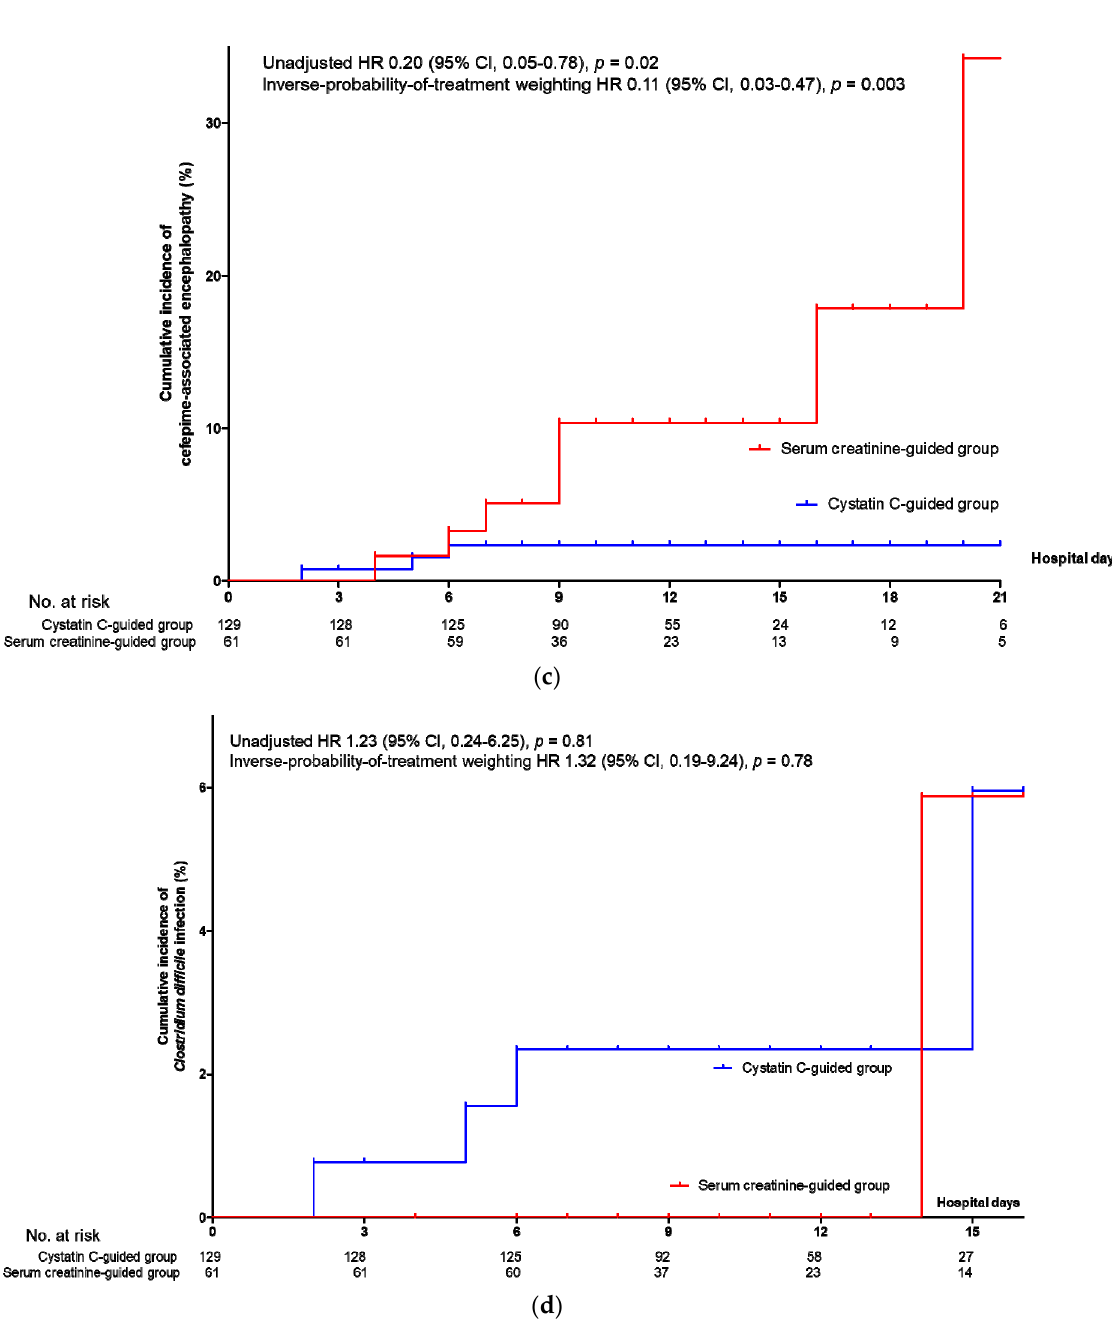
Figure 2. Difference in mortality and cefepime-associated morbidities among hospitalized patients with pneumonia. ( a ) Survival rates among patients in the cystatin C-guided and serum creatinine-guided groups. Cumulative incidence of acute kidney injury ( b ), cefepime-associated encephalopathy ( c ), and Clostridium difficile infection ( d ) among patients in the cystatin C-guided and serum creatinine-guided groups. Abbreviations: CI, confidential intervals; HR, hazard ratio.